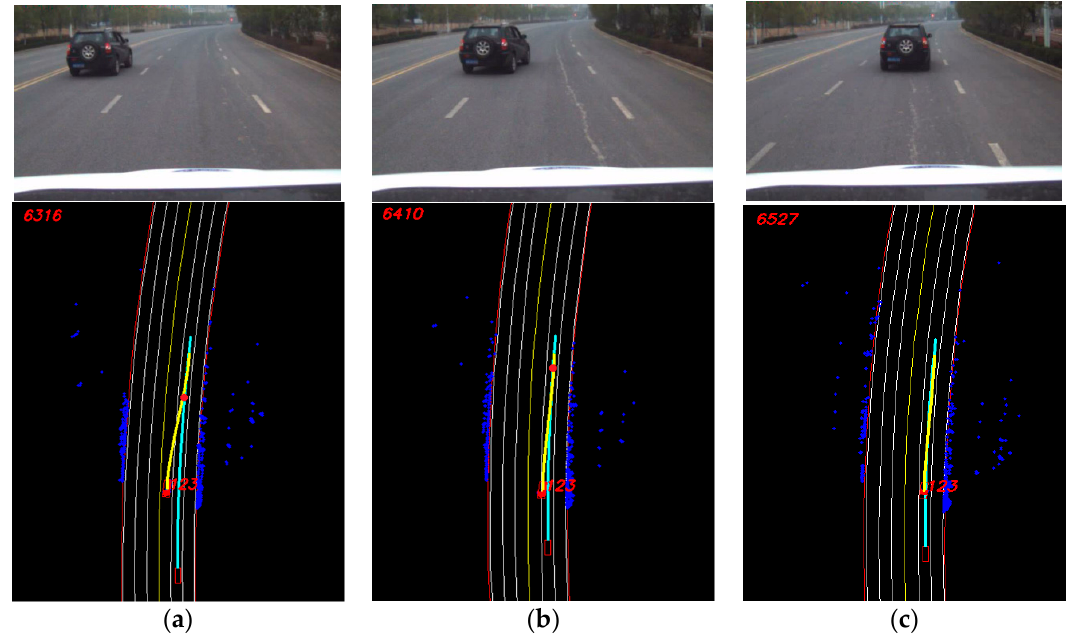
Figure 18. Collision avoidance on a winding road. ( a ) A collision point is detected; ( b ) decelerate to avoid the collision; ( c ) avoid potential collision successfully. The red number represents the ID of the detected obstacle which is unique.